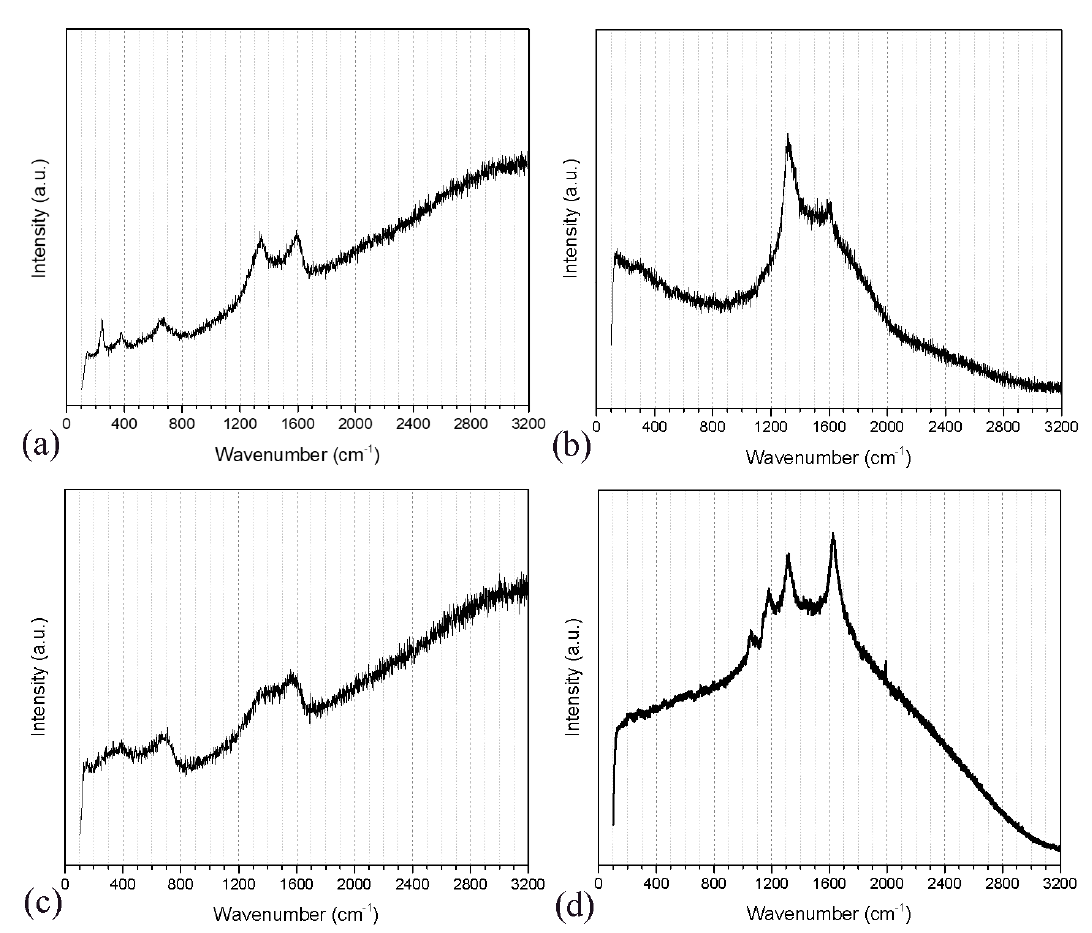
Figure 11. Raman spectra of the mild steel panels after subjection in WSS for 96 h: ( a ) Steel–WSS–blank , ( b ) Steel–WSS–Na 2 HPO 4 , ( c ) Steel–WSS–MBT , ( d ) Steel–WSS–Na 2 HPO 4 –MBT .